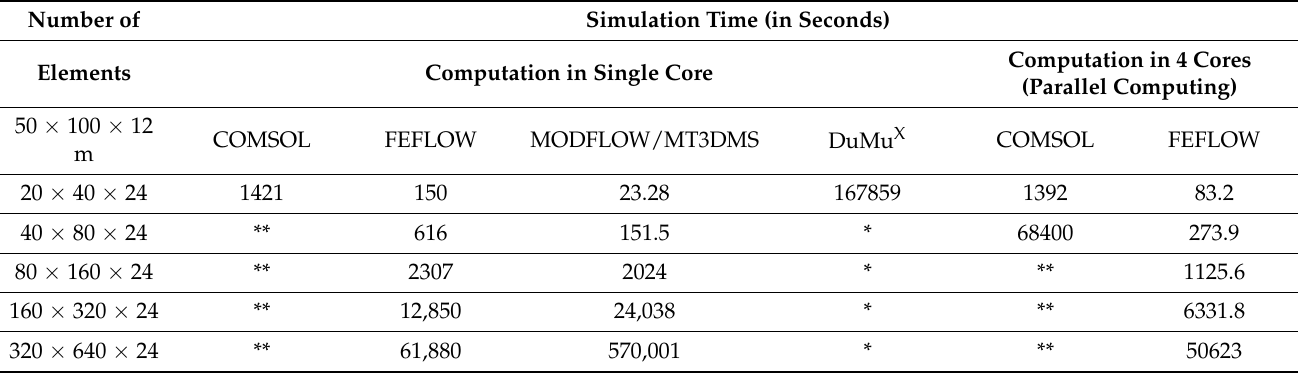
Table 2. Simulation times for Problem 3 (3D layered domain) with respect to different mesh